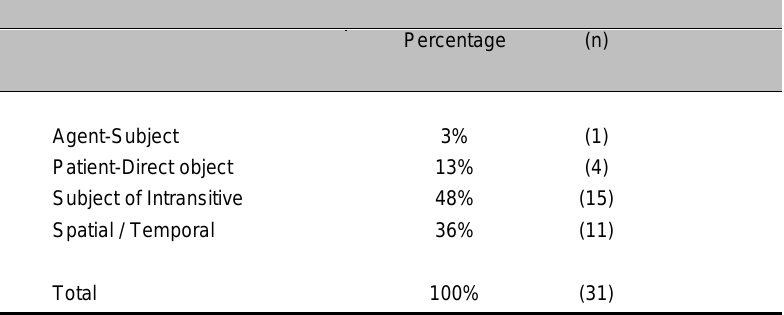
Table 2: Argument functions of the referent in the subordinate in adjectival subordinates with intrusive